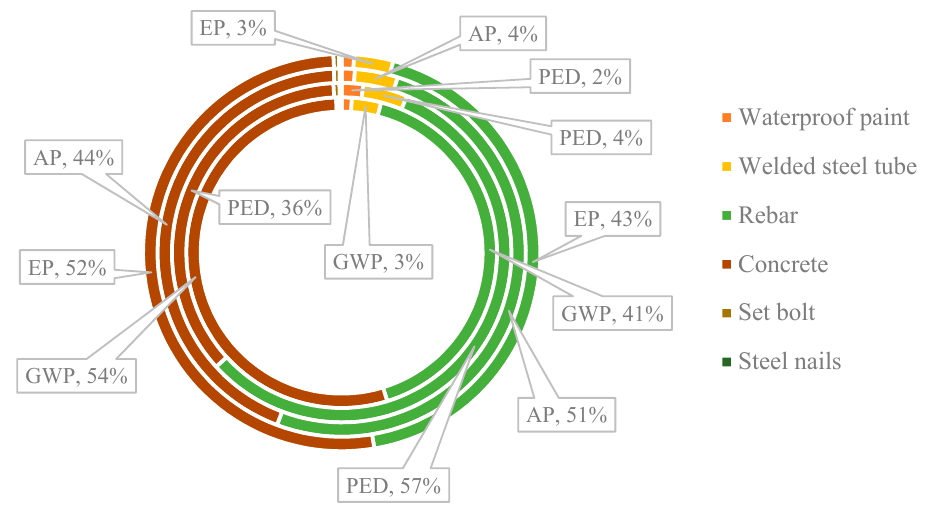
Figure 4. Contributions of main materials to the environmental burden of the ISFT (integrated secondary fermentation tank) module (only items contributed large than 1% are included). Note: GWP—global warming potential, PED—primary energy depletion, AP—acidification potential, EP—eutrophication potential.